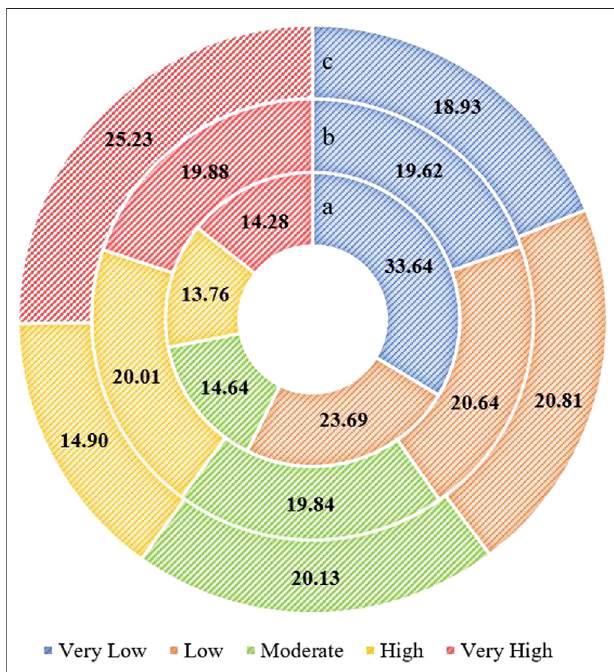
FIGURE 7 | (A) Success rate curve and (B) prediction rate curve AUROC results.